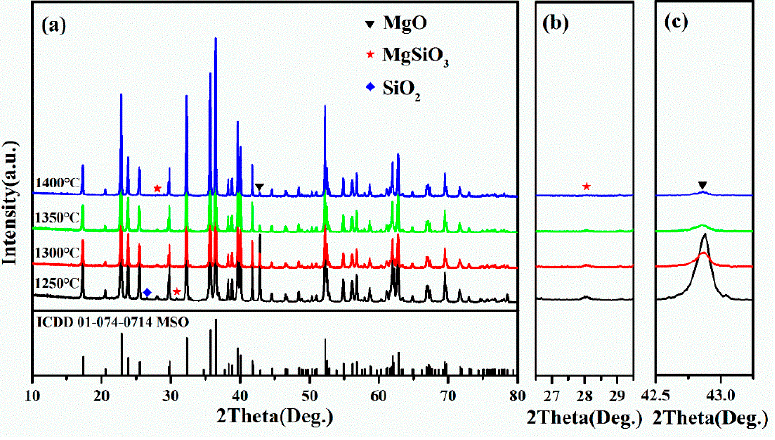
Figure 1. XRD patterns of the MSO powders calcined at different temperatures. ( a ) 10°–80°, ( b ) 26.5°–29.5°, and ( c ) 42.5°–43.25°.